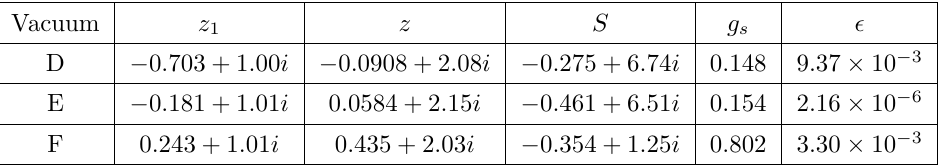
Table 3 . Explicit values of stabilized moduli and on-sell quantities in M Pl = 1 unit.